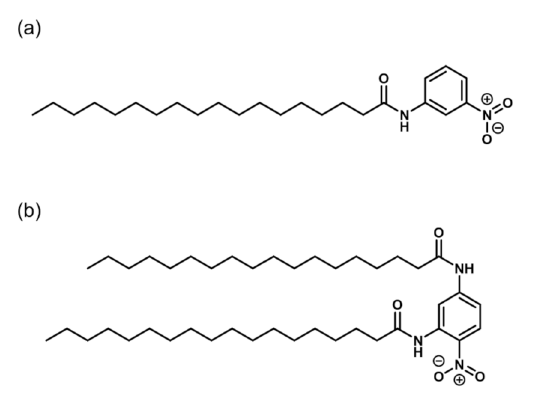
Figure 1. Molecular structures of ( a ) MANA and ( b )